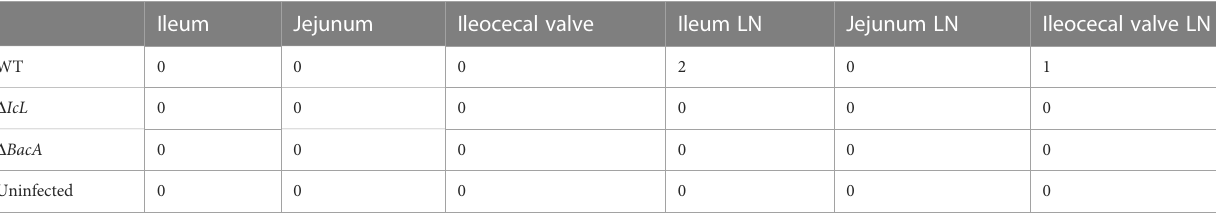
TABLE 3 Number of animals with MAP qPCR positive